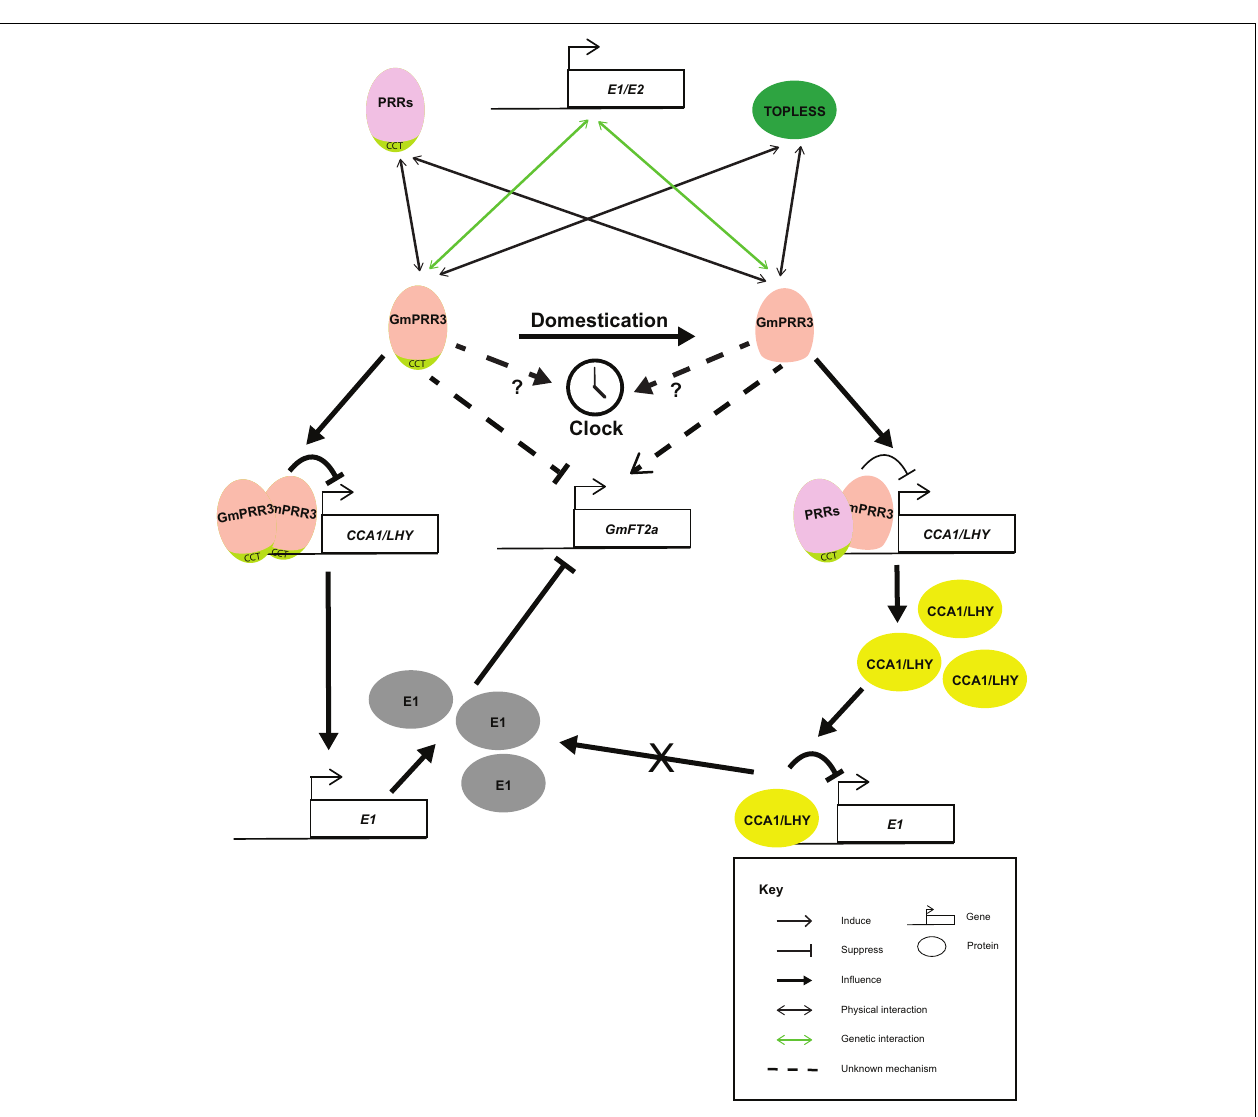
FIGURE 1 | Cartoon summarizing the known interactions of GmPRR3a and GmPRR3b. GmPRR3s are genetically interacting with E1 or E2 loci in controlling flowering time and maturation of soybean probably through the regulation of GmFT2a expression. During domestication and soybean improvement, alleles of GmPRR3s without CCT domain were selected. GmPRR3s without CCT domain have weakened suppression of the expression of CCA1 / LHY genes. The interaction of GmPRR3s without CCT domain may rely on other PRR proteins. Thus, the derepression of CCA1 / LHY will in turn suppress the expression of E1 . The suppression of E1 maybe one of the routes that GmPRR3s without CCT domain derepress GmFT2a .